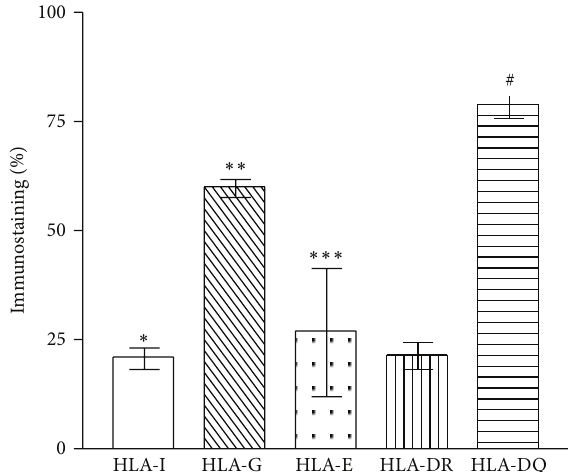
Figure 2: Quantitative expression of HLA class Ia (-A, -B, and -C), HLA class II (DR and DQ), and HLA class Ib (HLA-G and HLA- E) in invasive ductal carcinoma of the breast. Kruskal-Wallis, 𝑃 < 0.001 ; post hoc Dunn’s multiple comparison test, ∗ HLA-I versus HLA-G and HLA-DQ ( 𝑃 < 0.001 ), and ∗∗ HLA-G versus HLA- DQ, HLA-DR and HLA-E, ( 𝑃 < 0.01 ); ∗∗∗ HLA-E versus HLA-DQ ( 𝑃 < 0.001 ), # HLA-DR versus HLA-DQ ( 𝑃 < 0.001